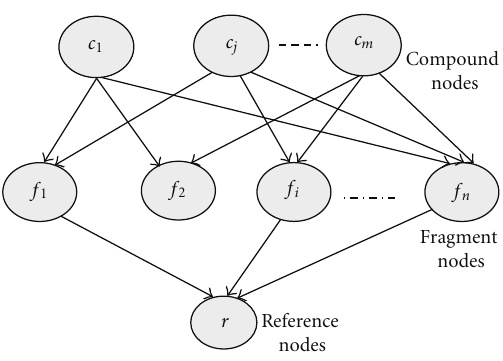
Figure 1: Bayesian inference network